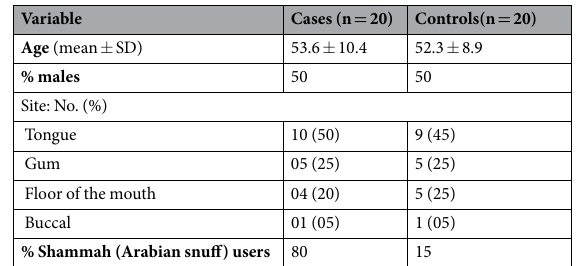
Table 1. Characteristics of the cases and control subjects included in the study (N =